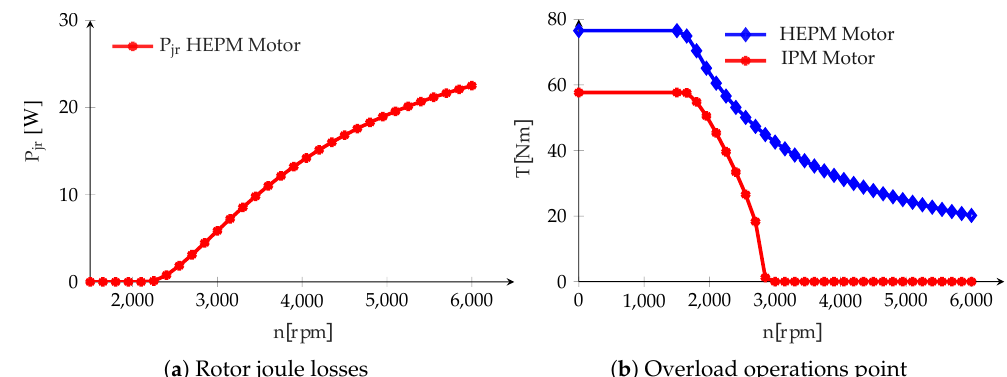
Figure 12. Rotor Joule losses and Torque with flux excitation in add to the PM